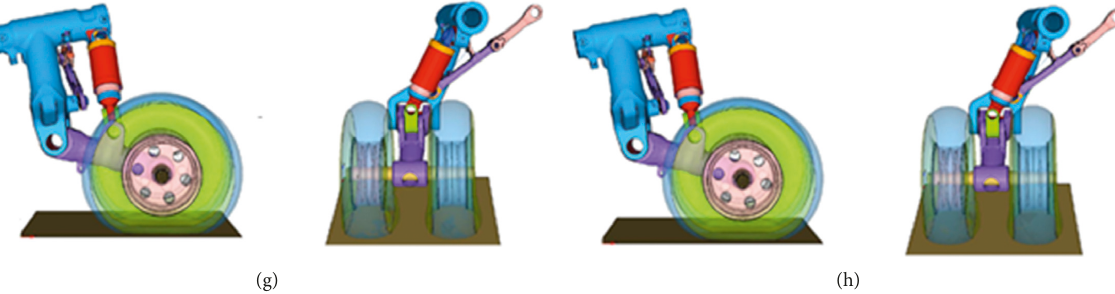
Figure 28: Numerical frames of the drop test simulation: (a) t 1 � 0ms; (b) t 2 � 50ms; (c) t 3 � 80 ms; (d) t 4 � 120ms; (e) t 5 � 170ms; (f) t 6 � 210 ms; (g) t 7 � 340ms; (h) t 8 � 350ms.